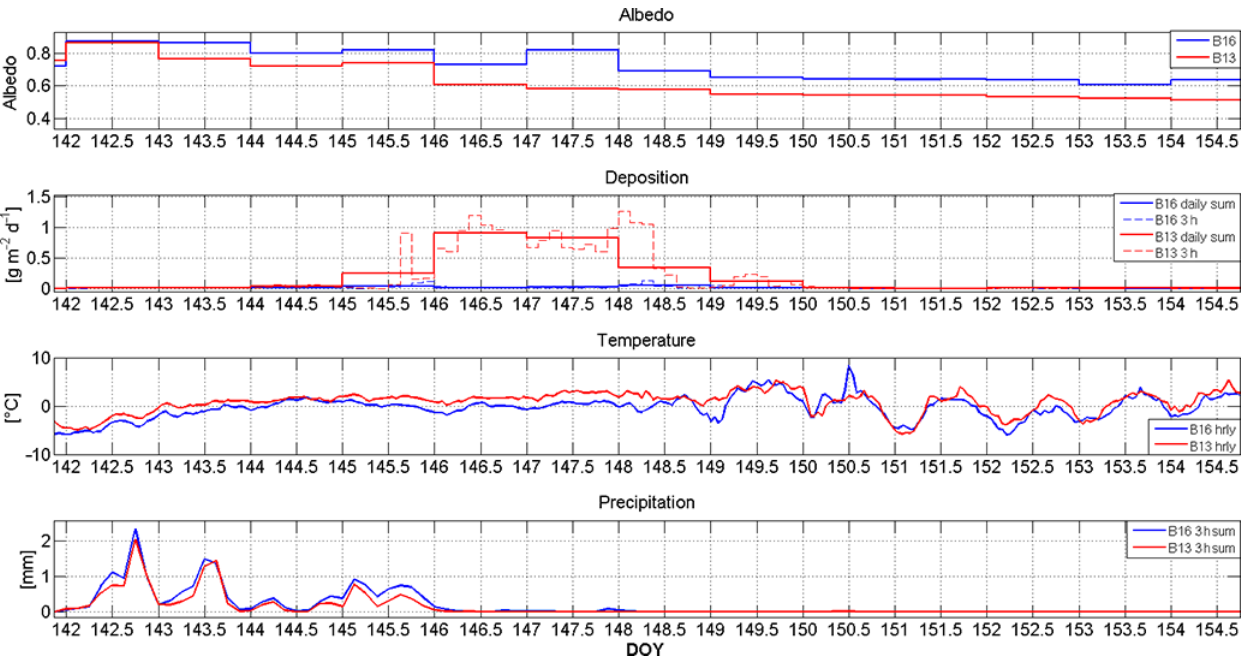
Figure 5. Observed albedo, simulated dust deposition, observed temperature and simulated precipitation dust event no. 2 at stations B16 (blue) and B13 (red). Modelled deposition is shown for 3h and daily